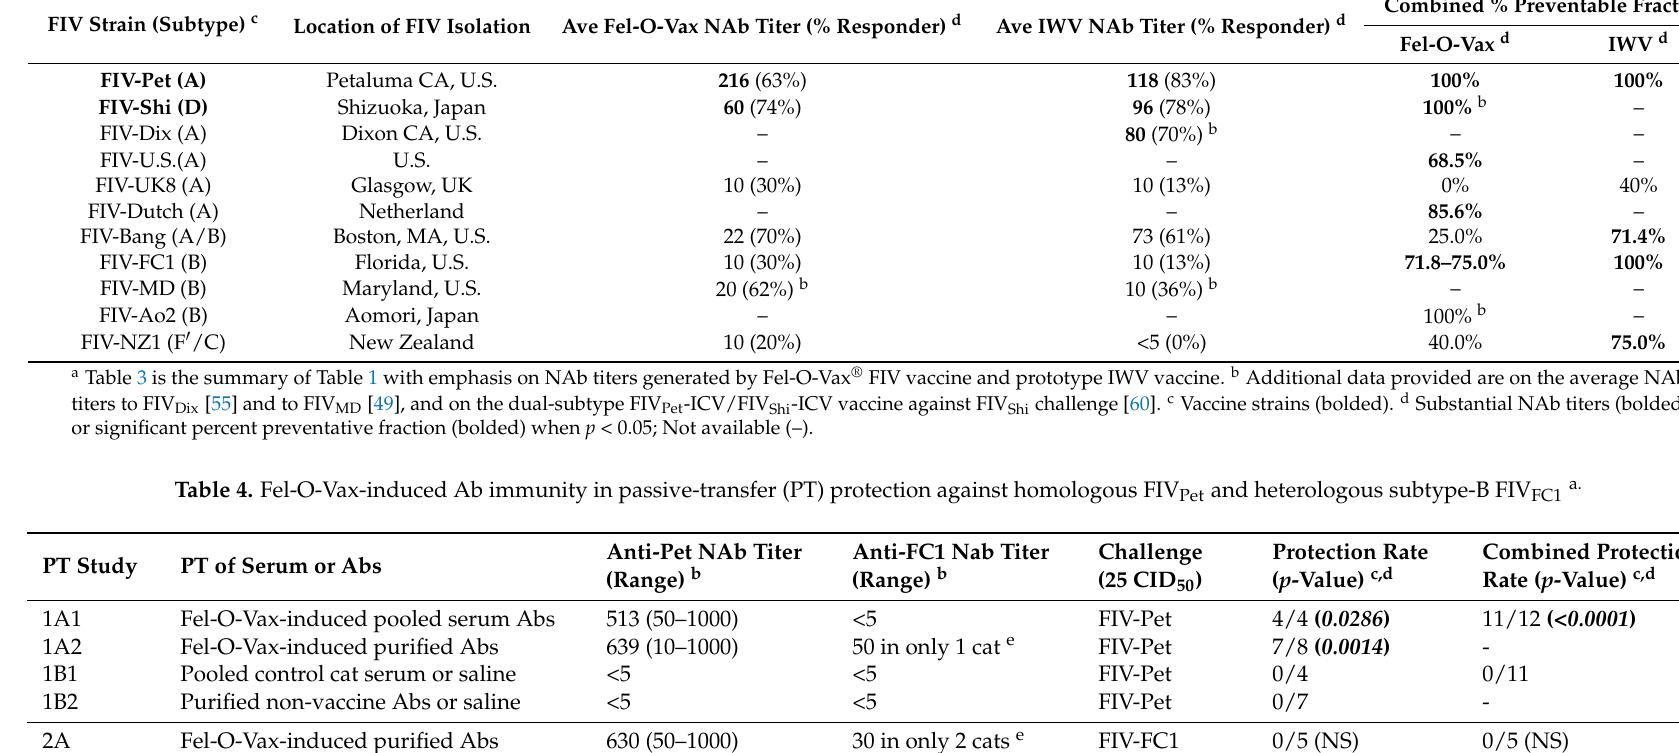
Pet (Pet) or FIV FC1 (FC1) present in PT cats at 6 days post-PT or 1